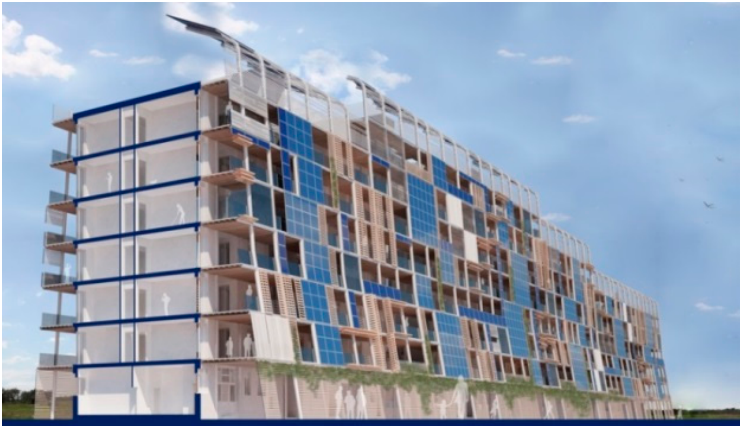
Figure 2. An example of retrofitting using the external steel frames.